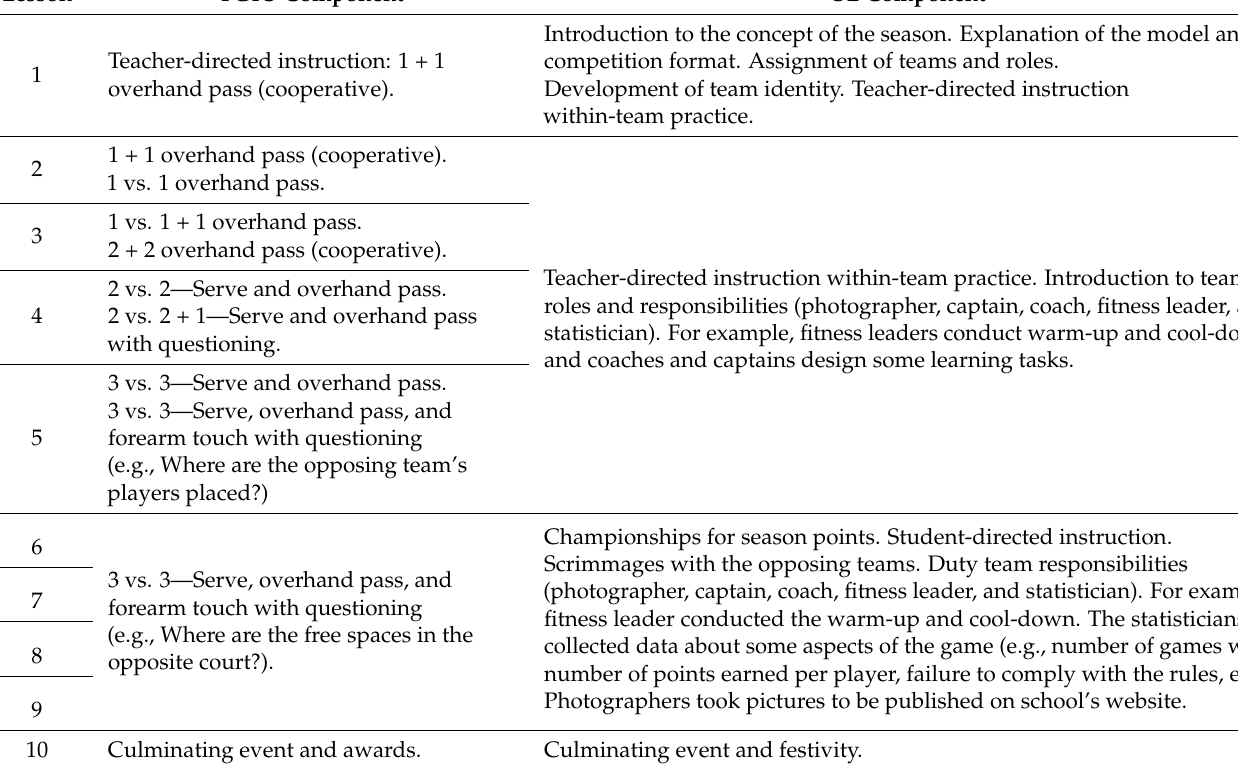
Table 3. Season plan for the hybrid teaching games for understanding/sport education (TGfU/SE) volleyball teaching unit.